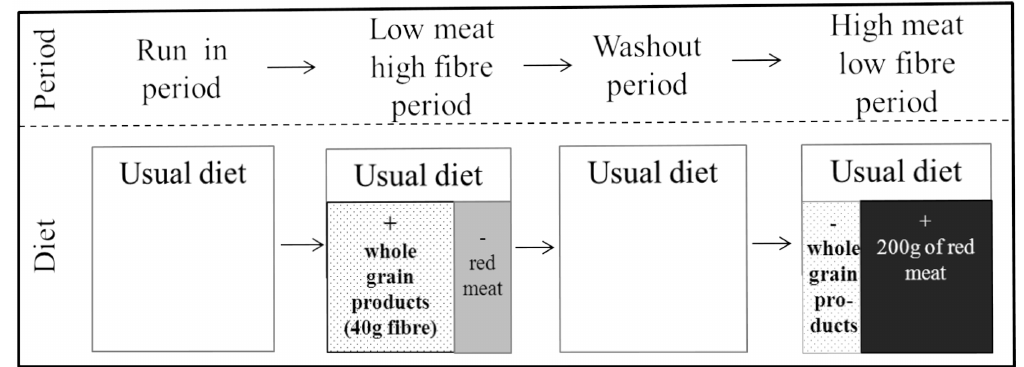
Figure 2. Diet plan for participants with diet succession: whole grain diet, washout period and red meat diet.